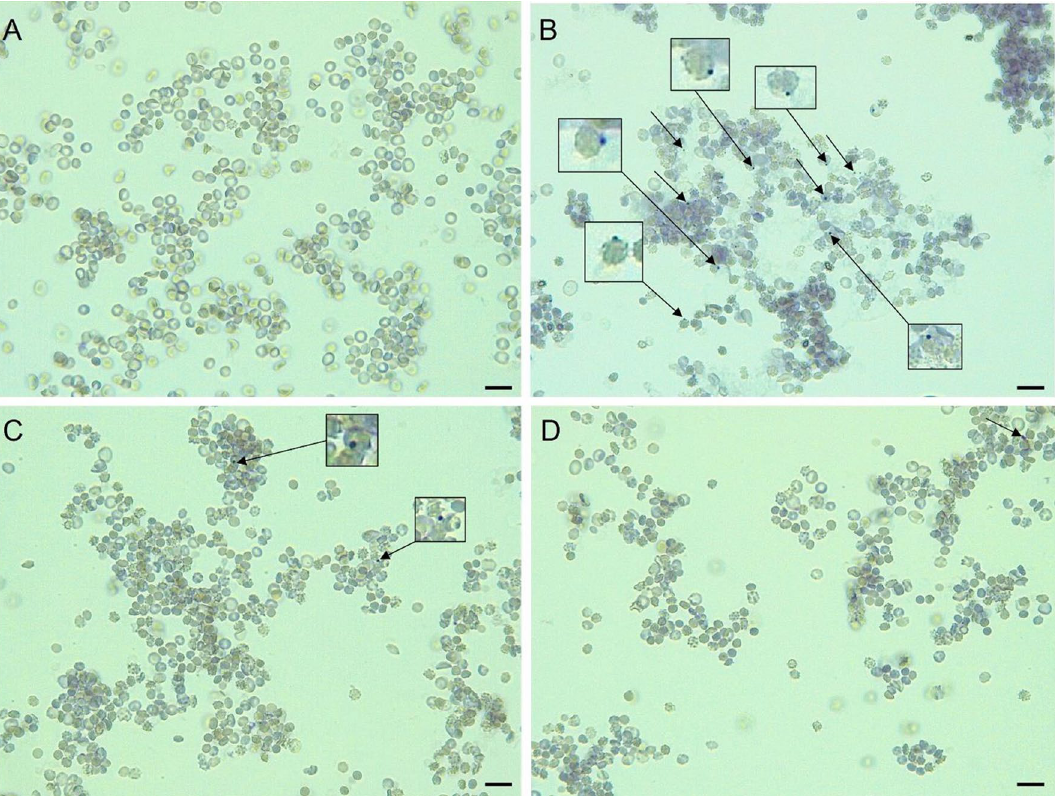
Figure 6. Supravital visualization of Heinz bodies in RBC stained with methyl violet (0.5%, 45 min, 37 °C) in light microscopy: ( A ) control RBC (PBS), ( B ) 60 mM AAPH (4 h); ( C ) derivative 27 (0.1 mg/mL, 20 min preincubation) + 60 mM AAPH (4 h); ( D ) Trolox (0.1 mg/mL, 20 min preincubation) + 60 mM AAPH (4 h). Inserts in ( B ) and ( C ) magnification of RBC with Heinz bodies visible as small, stained granules next to the RBC membrane. The representative images for a series of experiments are presented. Scale bar = 10